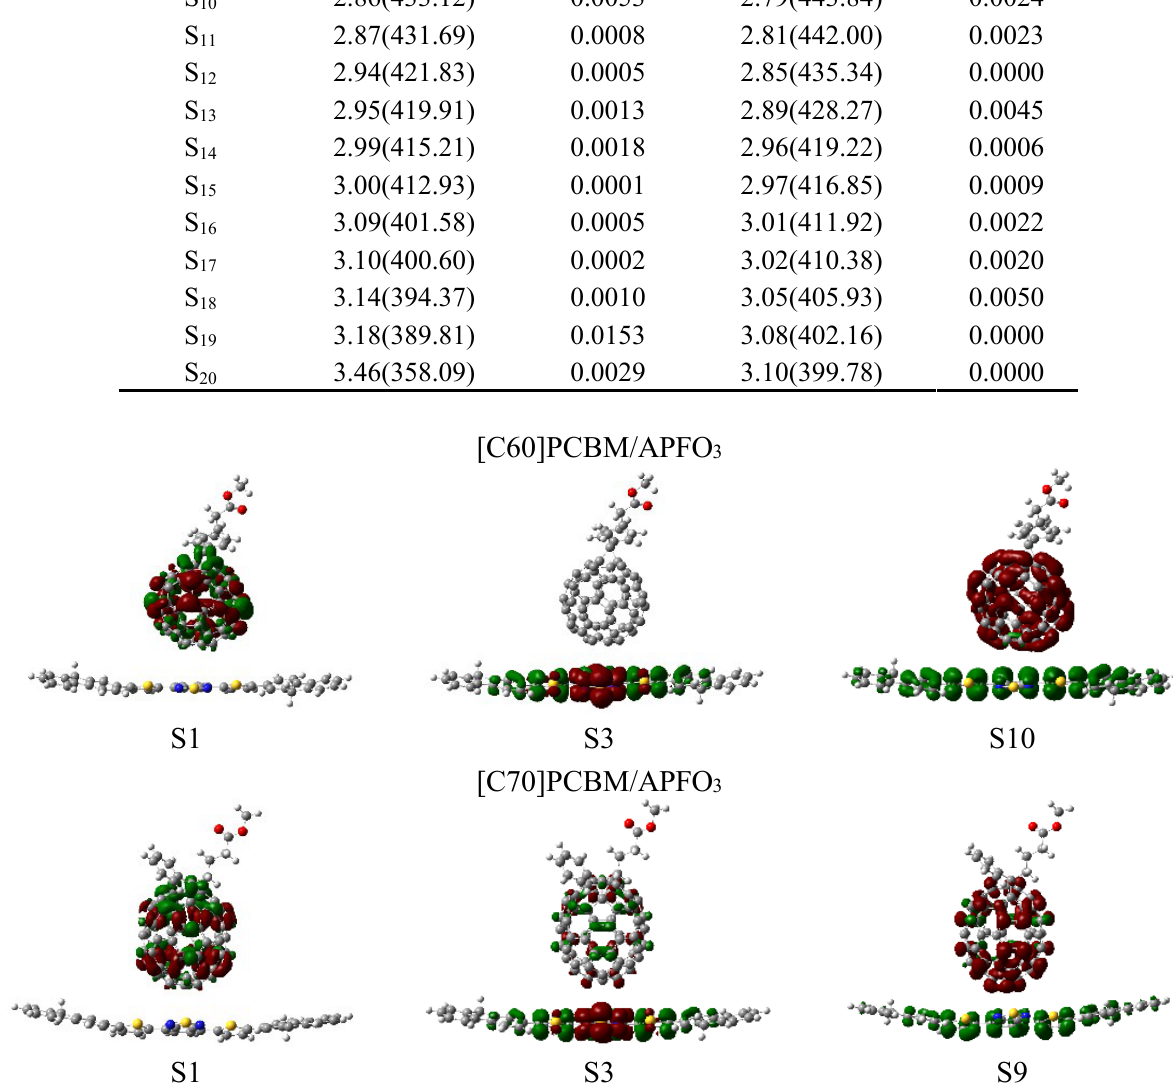
Figure 6. Charge difference density (CDD) of [C60]PCBM/APFO 3 and [C70]PCBM/APFO 3